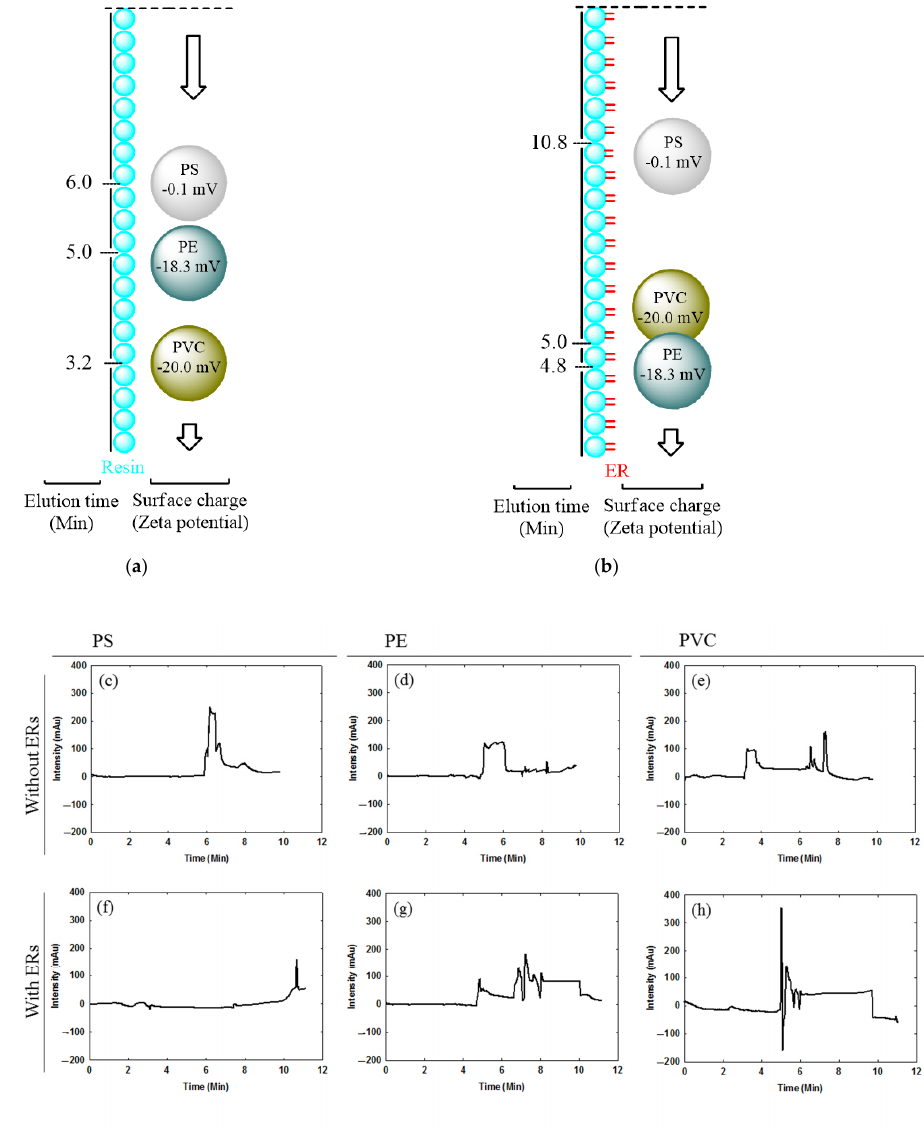
Figure 3. Validation of the interaction between micro-plastics and estrogen receptors by liquid chromatography. Schematic diagram of surface charge and elution time of micro-plastics without ERs ( a ) and with immobilized ERs ( b ) in liquid chromatography. In the absence of ERs, the micro-plastics interacted with Ni-NTA resins, and the measured elution time was ( c ) 6 min for PS, ( d ) 5 min for PE and ( e ) 3.2 min for PVC. After the ERs were immobilized on Ni-NTA resins, the micro-plastics interacted with the ERs and the measured elution times were ( f ) 10.8 min for PS, ( g ) 4.9 min for PE and ( h ) 5 min for PVC. The mobile phase was PBS at 25 μ L/min including about 5 particles of micro-plastics.